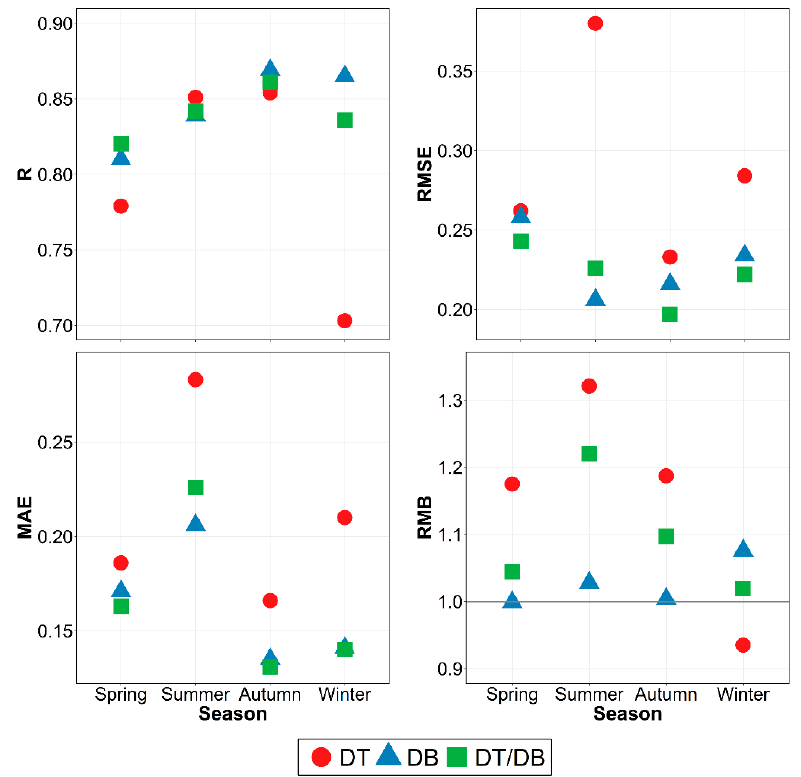
Figure 5. Error statistics for DT, DB, and DT / DB products against AERONET AOD ground-observed measurements in the four seasons.